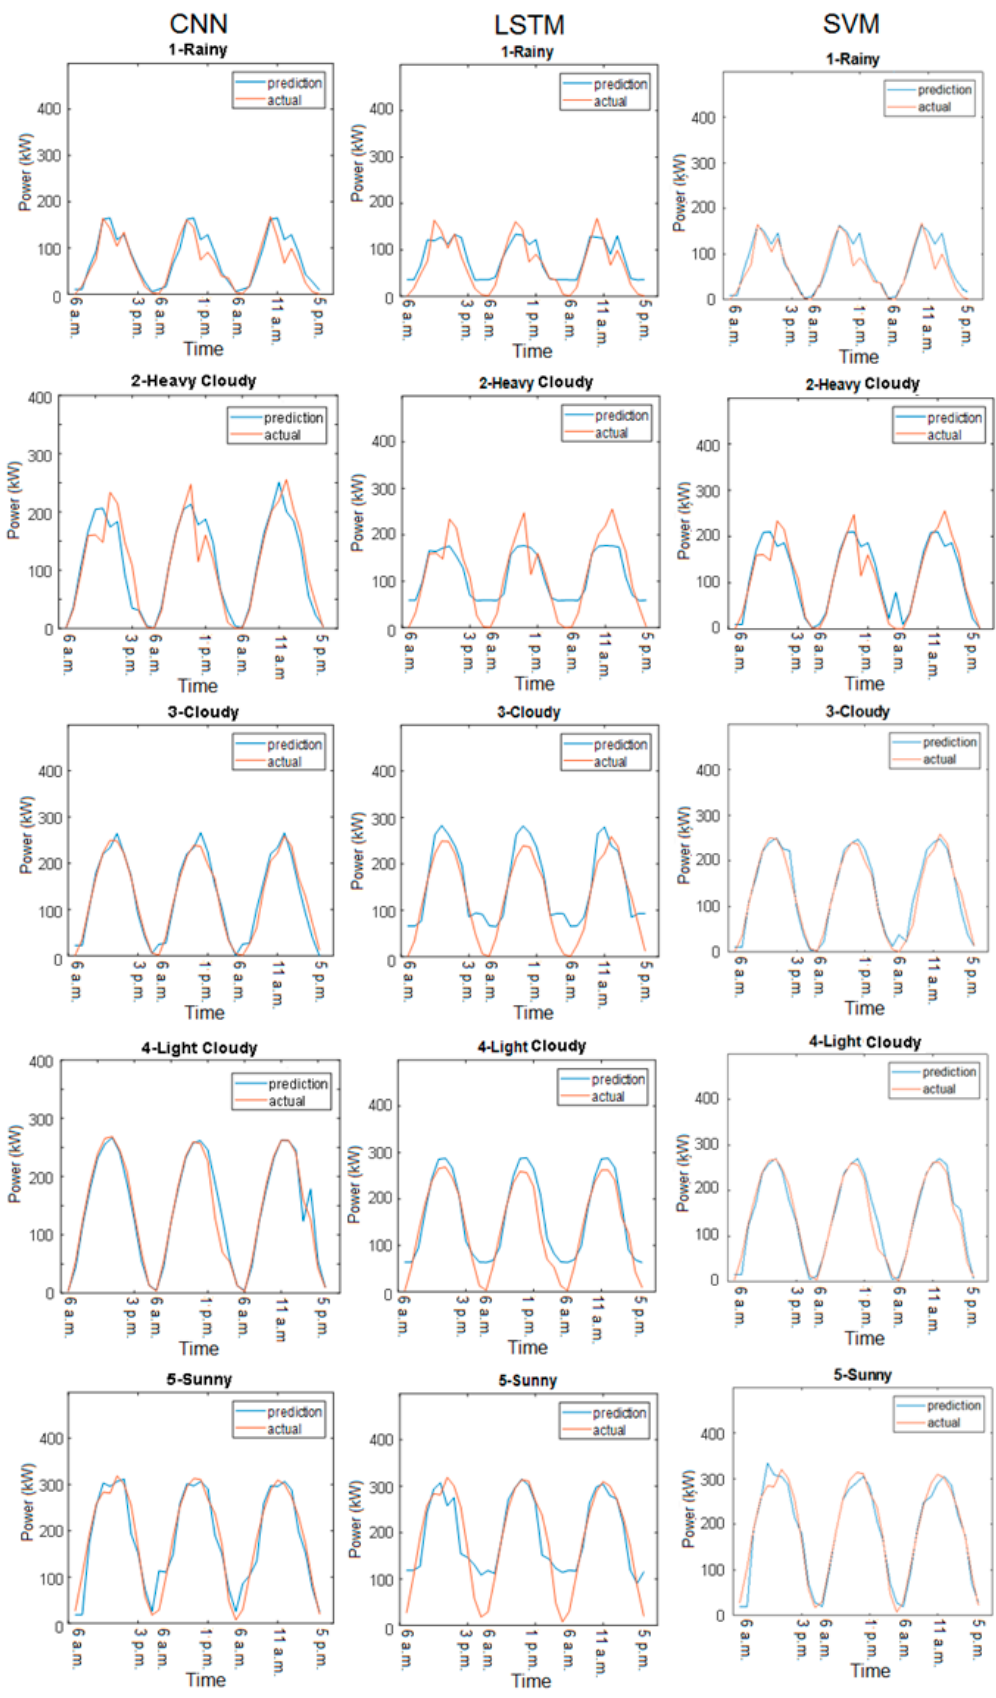
Figure 13. Forecasting results comparison without the SSA integration.